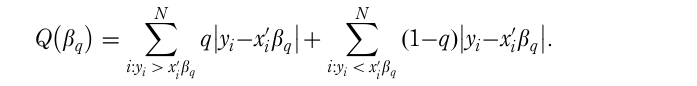
Figure 2. Scatter of household saving rates and household